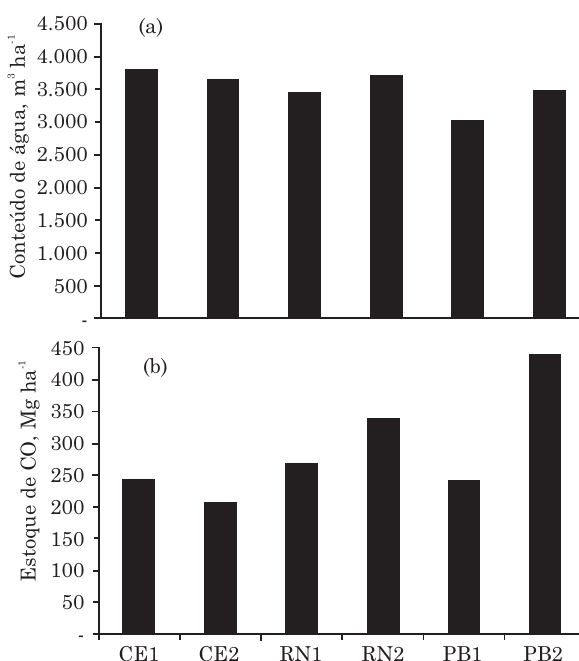
Figura 2. Capacidade de armazenamento de água (a) e estoque de carbono orgânico (b) dos perfis de solo a uma profundidade de 0,50 m de Organossolos localizados nos Estados do Ceará, do Rio Grande do Norte e da